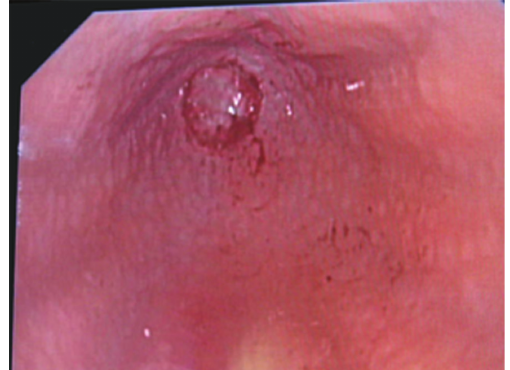
Figure 5: The endoscope was pushed into the passive stoma of sigmoidum. Here the bottom of the atresia is viewed. No fistula is seen.